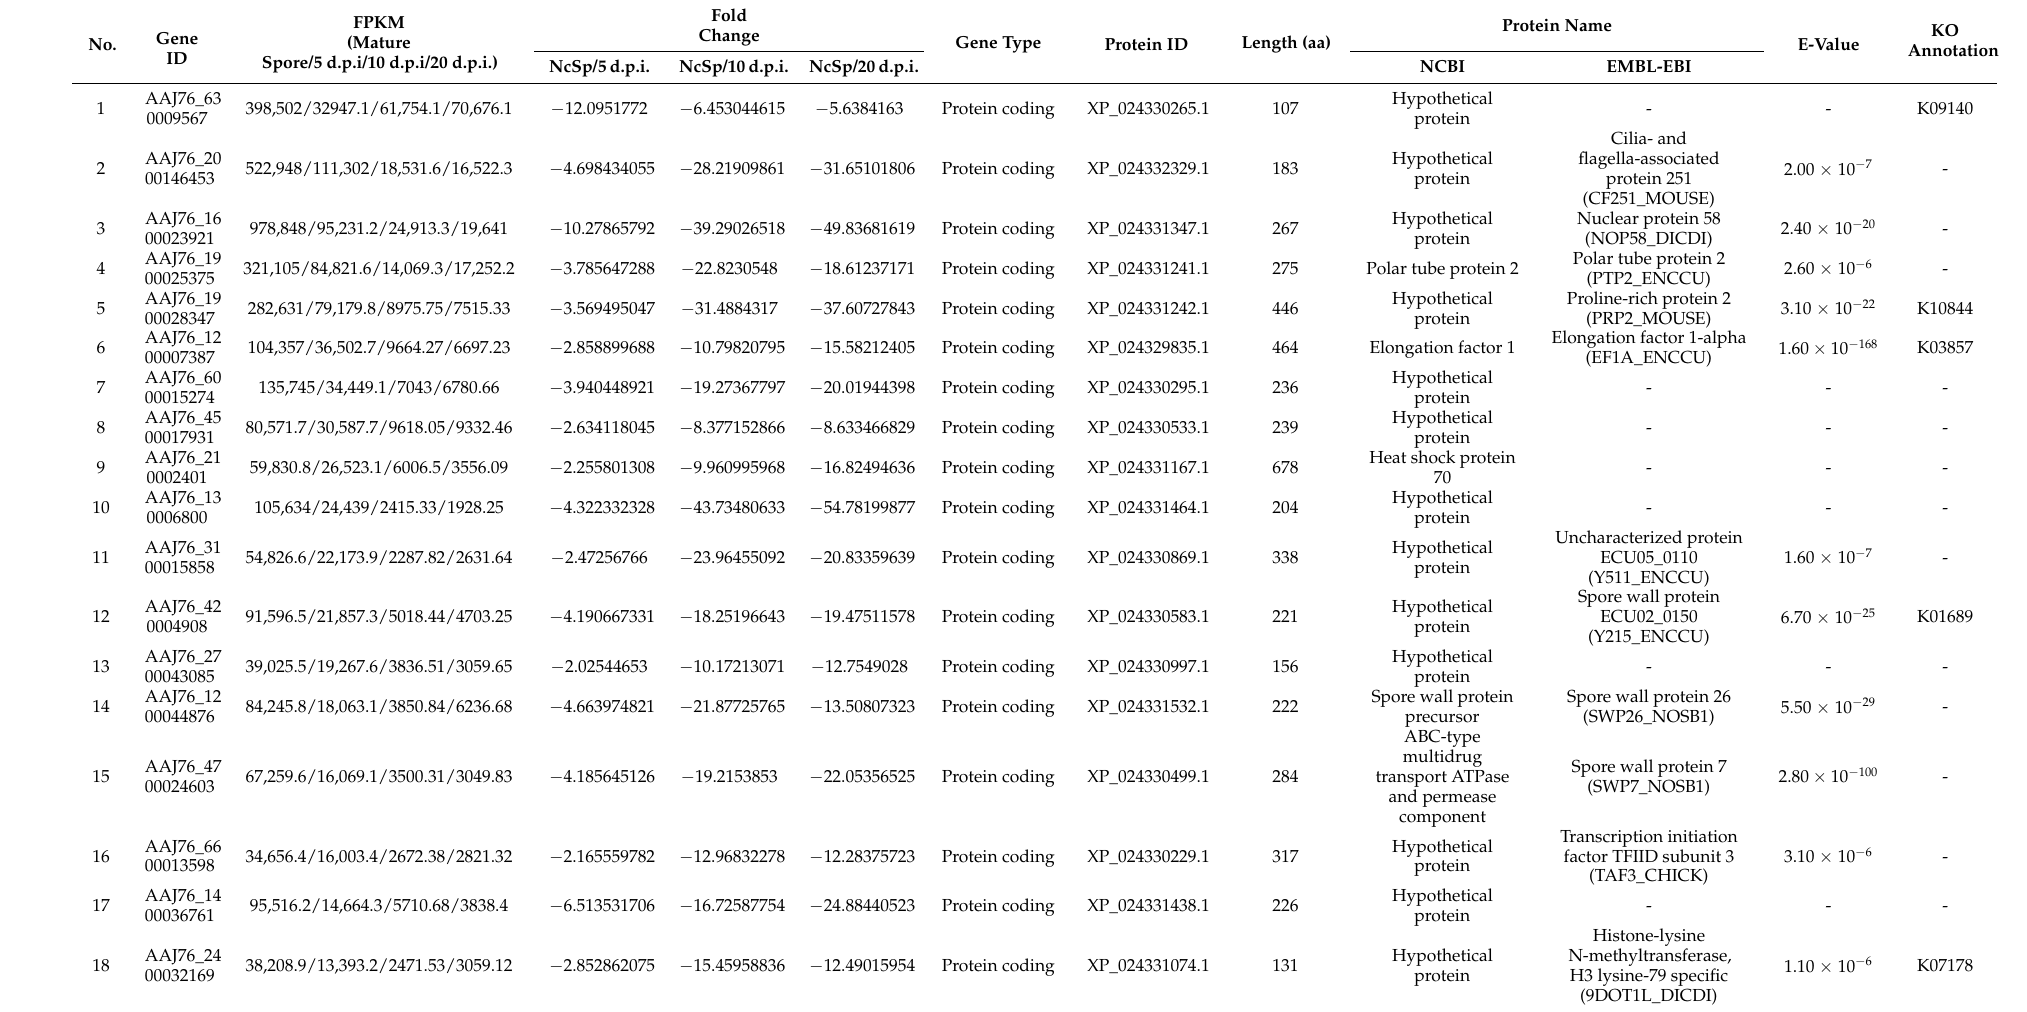
Table 2. List of downregulated common DEGs with FPKM values > 1000 at different times